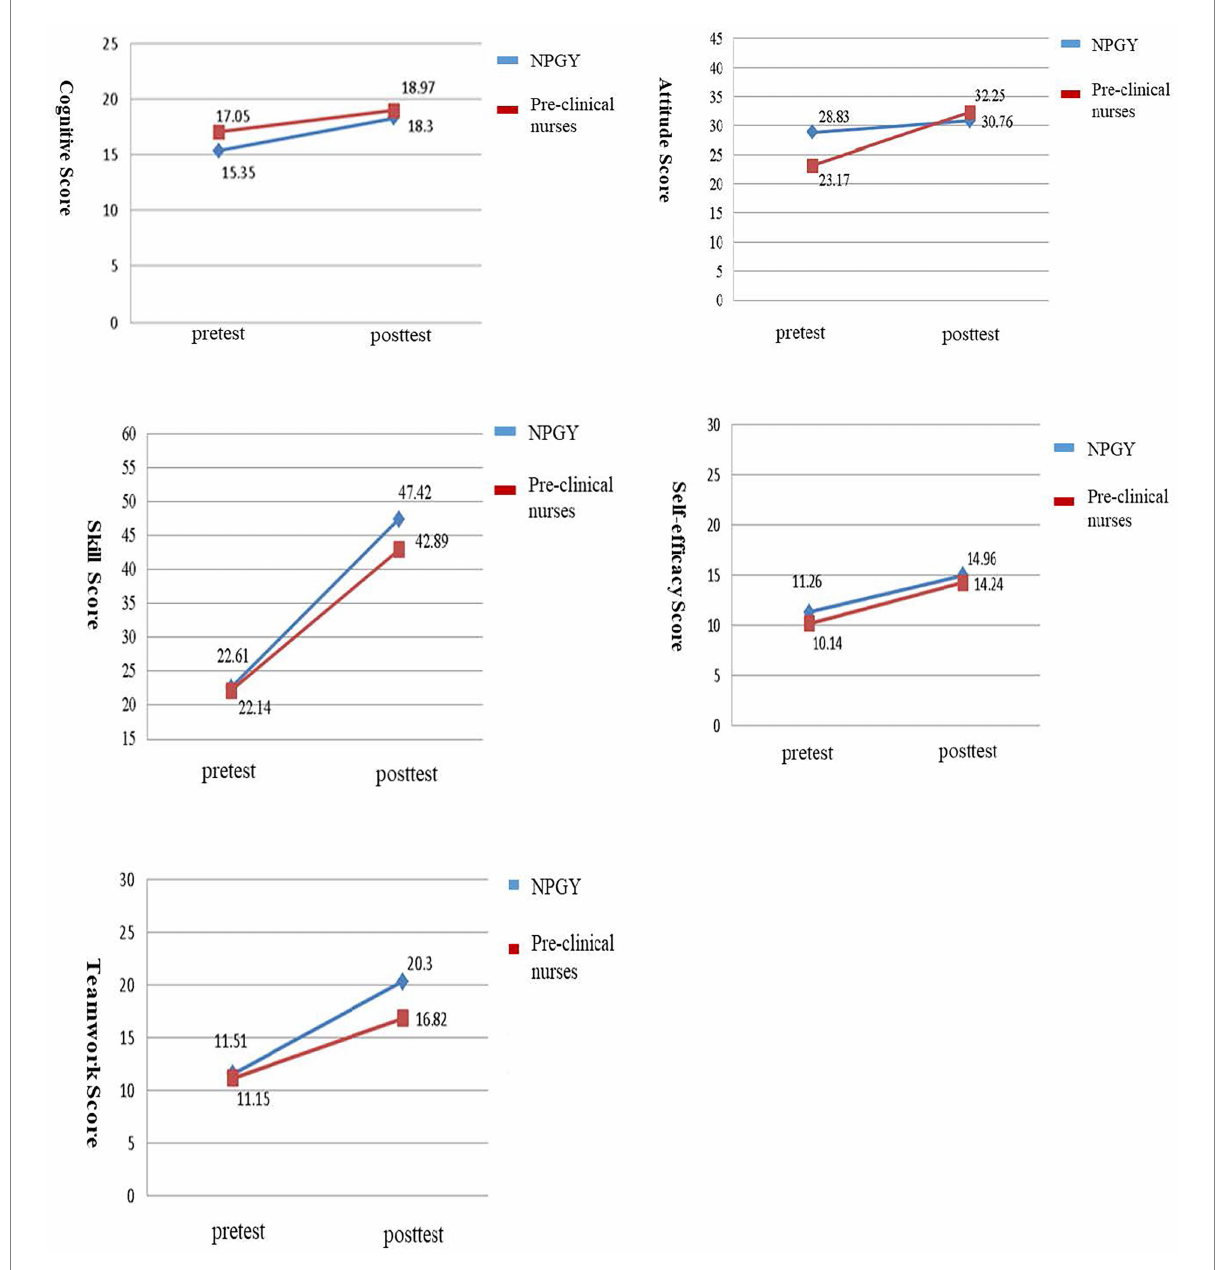
FIGURE 3 Change of cognitive, attitude, skill, self-efficacy and teamwork score in NPGY and pre-clinical nurses as assessed by